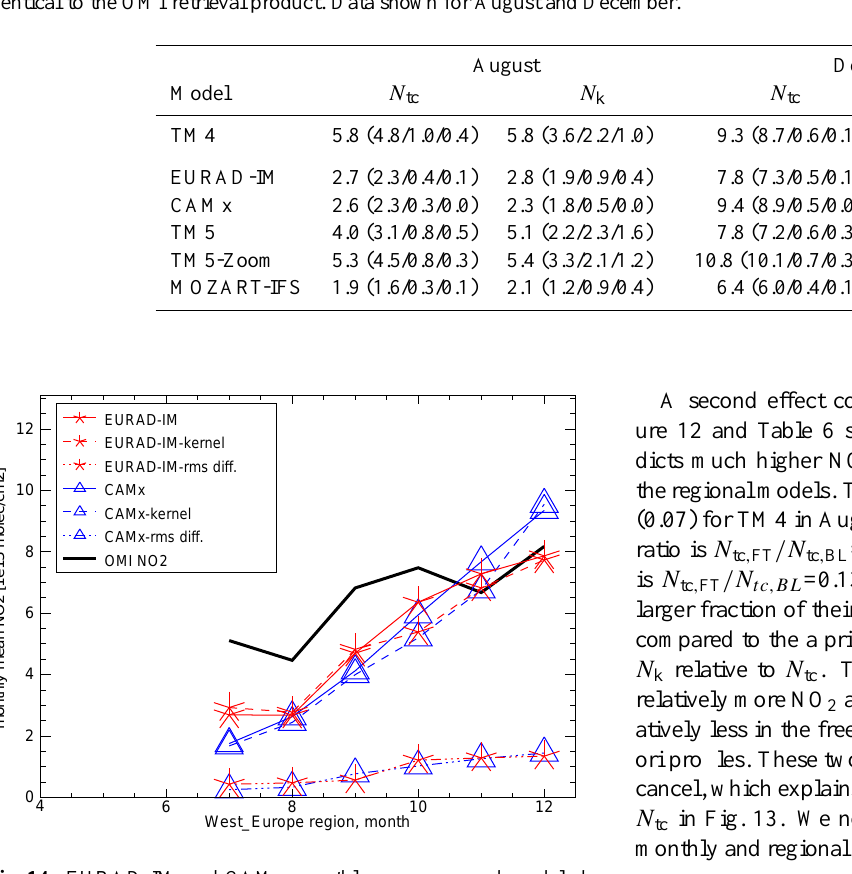
Table 6. Total tropospheric columns over West-Europe with/without kernel. In brackets the contribution from the boundary layer (1000– 800hPa), the free troposphere (800–200hPa) and the upper part of the free troposhere (500–200hPa) is given. Note that N k from TM4 is identical to the OMI retrieval product. Data shown for August and December.